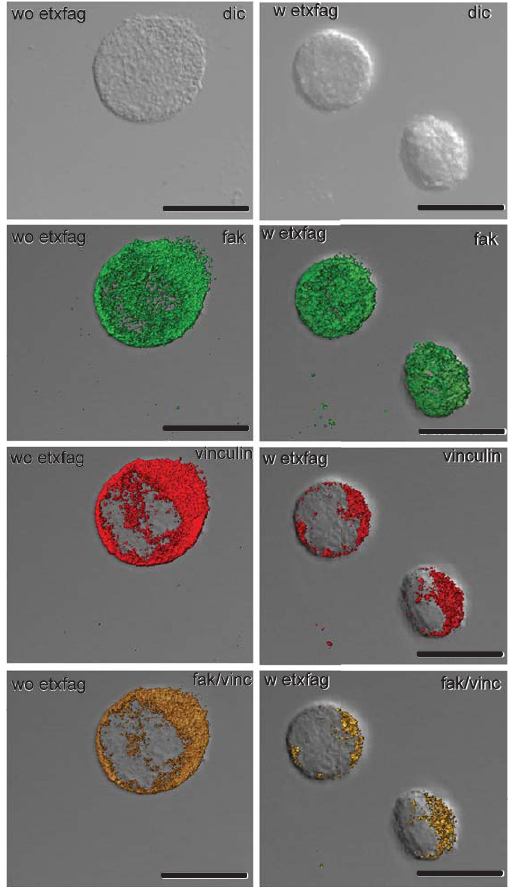
Supplementary Figure 1. Etxfag prevents vinculin association with fak in L1210 cells. L1210 cells treated or not with 1 × 10 − 7 M etxfag during 24h were seeded to FN/V-coated glass culture slides in serum-free medium for 2h. Cells were fixed with 4% paraformaldehyde then incubated with anti-fak primary antibody (1:100) and labelled with secondary antibody linked to Alexafluor 488 (green). Cells were also incubated with anti-vinculin primary antibody (1:100) and labelled with secondary antibody linked to Alexafluor 568-(red). Emitted fluorescence was detected through the appropriate wavelength window. Twenty images were captured with a 0.25 (cid:3) m z-step. Surfacic reconstructions were realized from L1210 cells treated with (right row) or without etxfag (left row). Differential interferential contrast imaging of L1210 cells treated or not by etxfag was proceeded (right and left row, upper panel). Upper panels represent fak labelling (green), middle panels represent vinculin labelling (red) and bottom panels represent colocalization between fak and vinculin (gold). A representative image of three independent experiments was shown. Scale bar: 10 (cid:3)